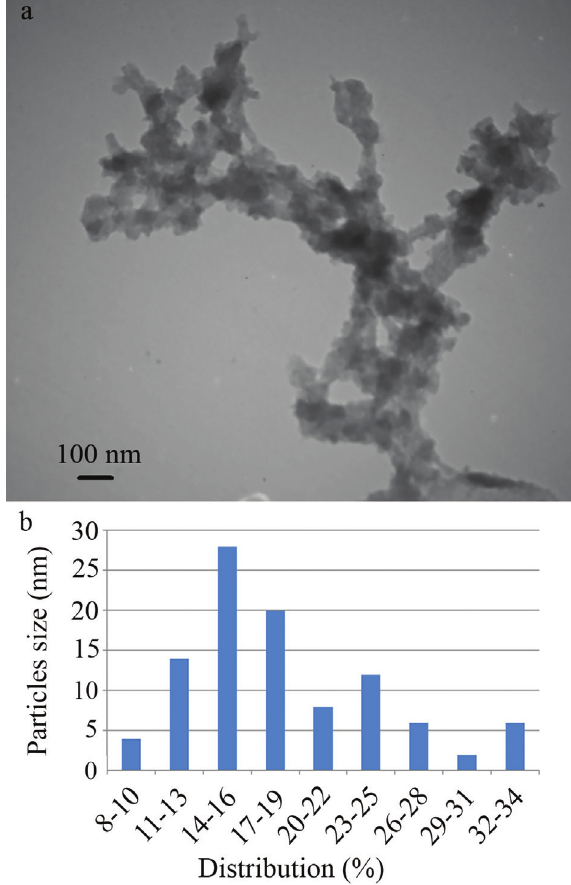
Figure 2: TEM micrograph of the biosynthesized INPs (a), which indicates that nanoparticles are spherical and surrounded by a biologic matrix from leaf extract, and corresponding particle size distribution histogram (b), more TEM image is provided in supplementary materials as Figure S1.